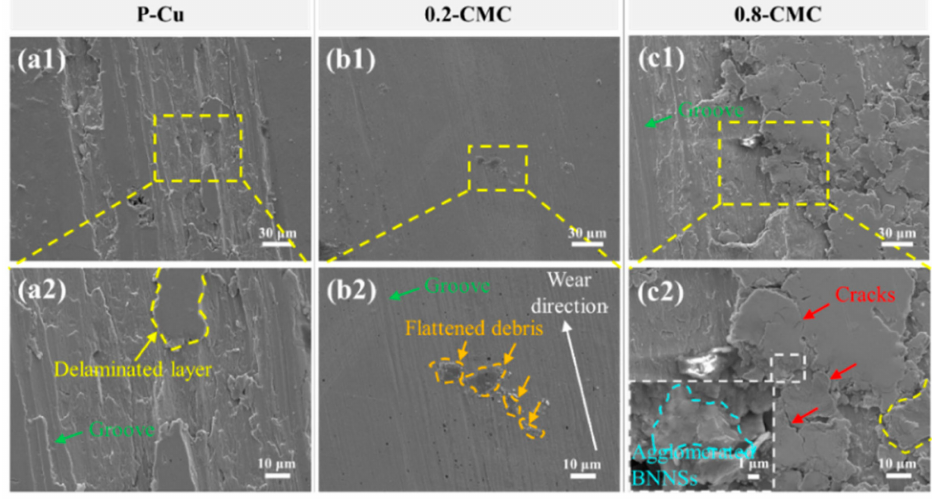
Figure 10. SEM images of the wear tracks: ( a1 , a2 ) P-Cu, ( b1 , b2 ) 0.2-CMC, ( c1 , c2 )